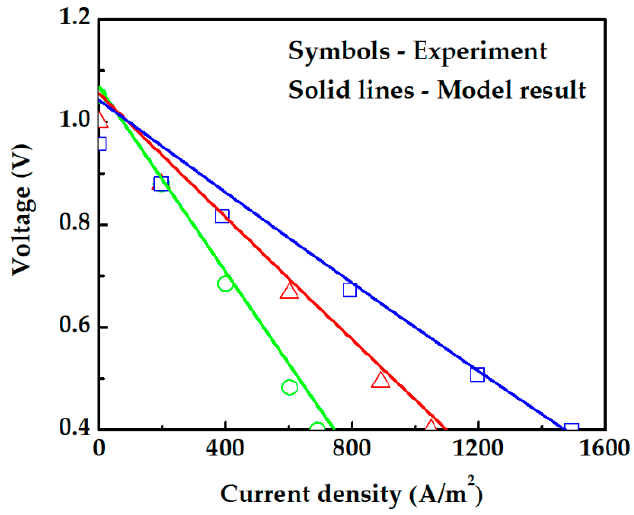
Figure 4. Comparison between theoretical modeling results and experiment [36]. The green circle ( # ), red triangle ( △ ), and blue square ( □ ) symbols are experimental data at temperatures of 1073 K, 1173 K, and 1273 K, respectively.